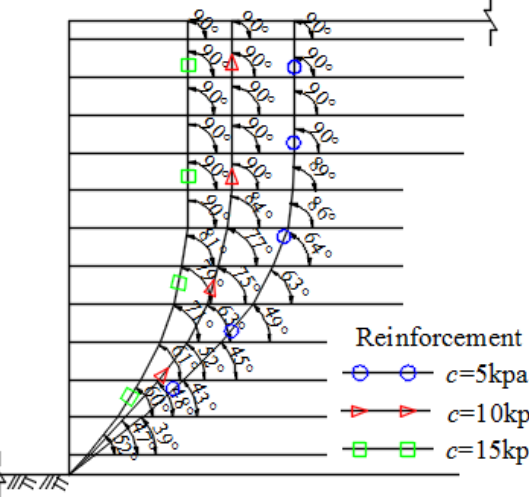
Figure 8. Inclination angle of slip surface and horizontal direction for various levels of cohesion.